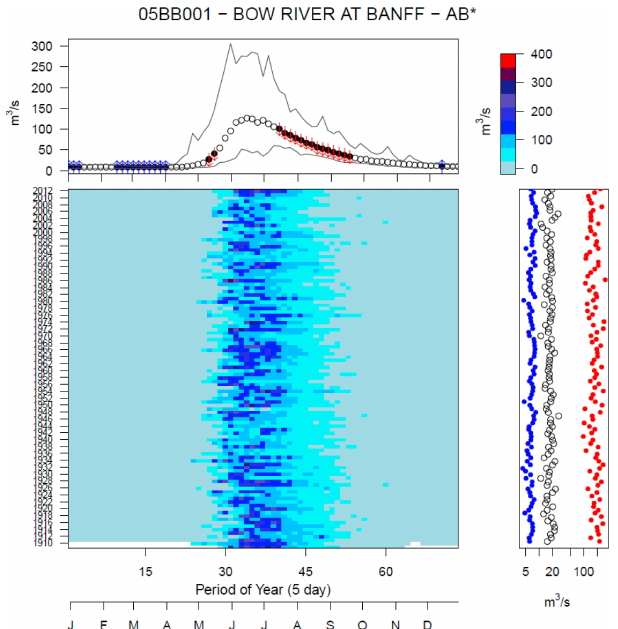
Figure 2. Plot of observed flows in the Reference Hydrologic Basin station 05BB001 Bow River at Banff, Alberta. The main panel shows the 5d periods of the year against the years of record. White space indicates missing observations and the colours represent flow magnitudes scaled according to the bar in the upper right corner. The upper panel shows the maximum, median and minimum flow for each of the 5d periods and red (blue) arrows indicate statis- tically significant decreases (increases) using Mann–Kendall τ at p ≤ 0 . 05. The panel on the right-hand side shows the annual min- ima, median (open circle), and maxima; statistically significant de- creasing (increasing) trends (Mann–Kendall τ at p ≤ 0 . 05) are in- dicated by red (blue). Whenever the station is a member of the ref- erence hydrologic basin network (RHBN), an ∗ appears at the end of the station